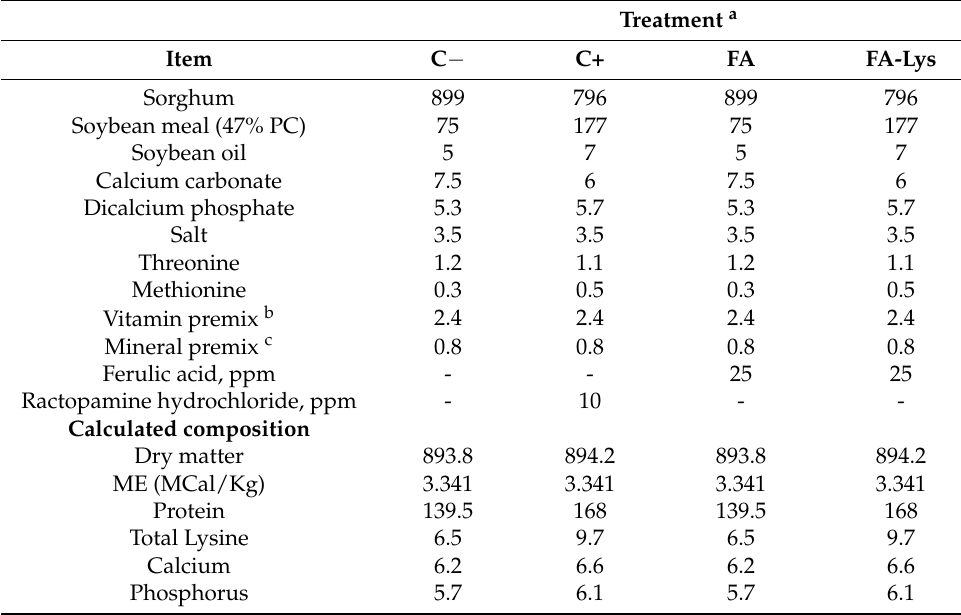
Ingredient composition and calculated nutrient composition (g/kg as-fed) of experimental